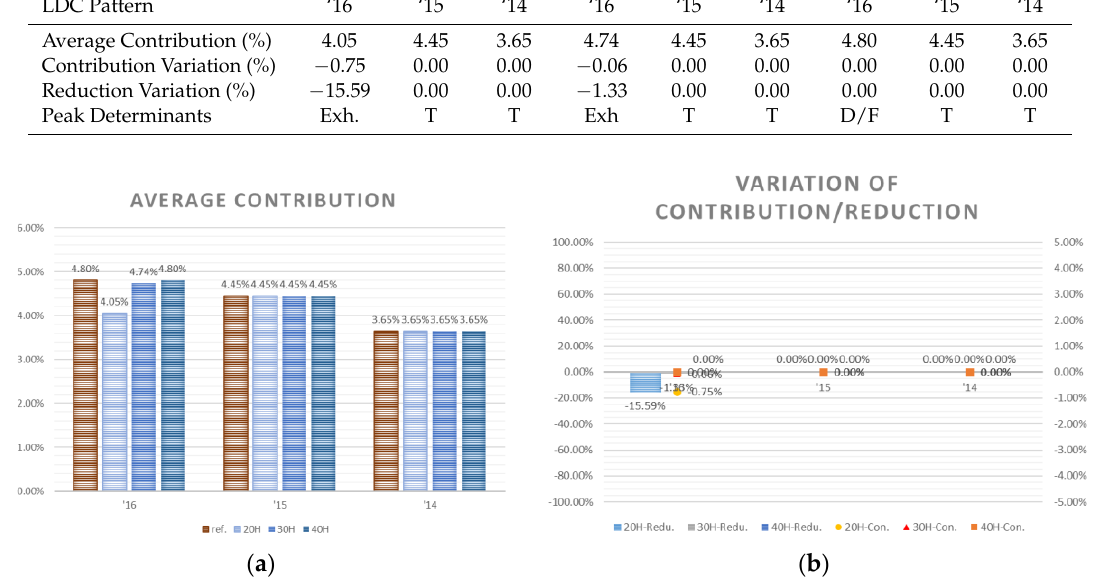
Figure 2. Sensitivity simulation results of maximum dispatch duration constraint: ( a ) Average contribution; ( b ) Variation of contribution and reduction.